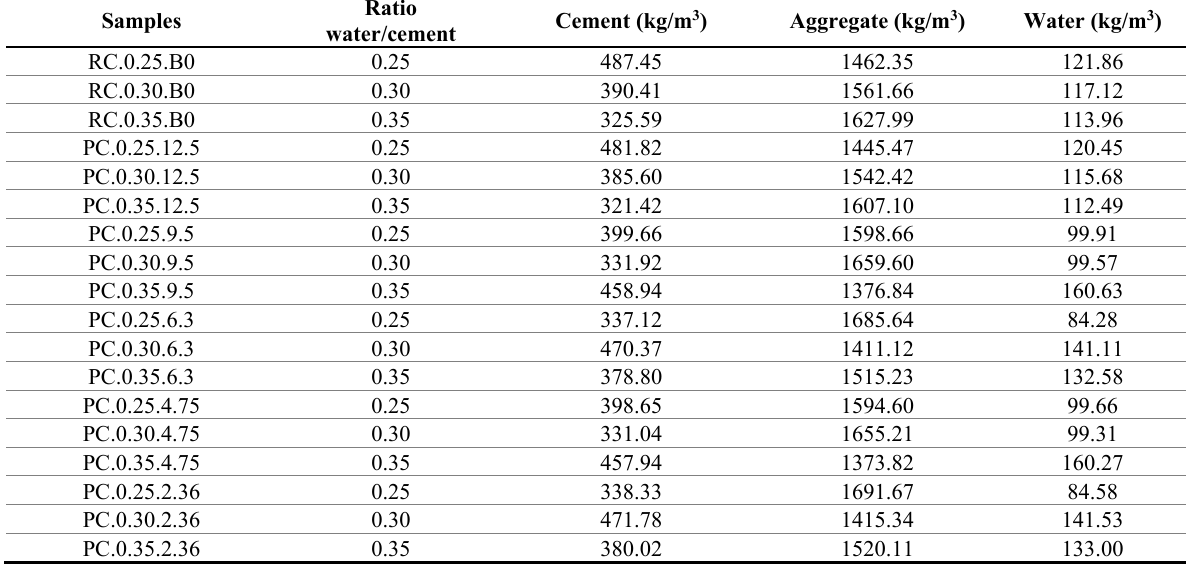
Table 2 P roportion of materials in the samples.